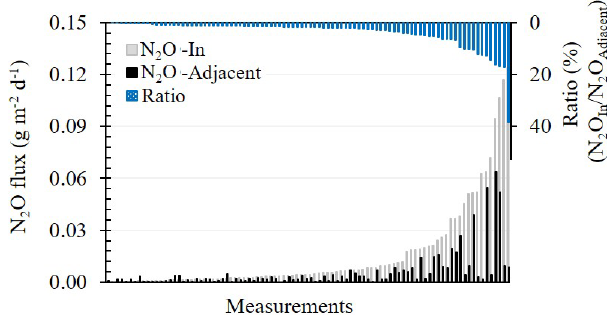
Figure 2. N 2 O fluxes measured in static chambers with a dripper in their base (N 2 O In ) and in static chambers with a dripper adja- cent to their base (N 2 O Adjacent ), and the ratio between N 2 O In and N 2 O Adjacent at each one of the 12 sampling locations on all sam- pling days.